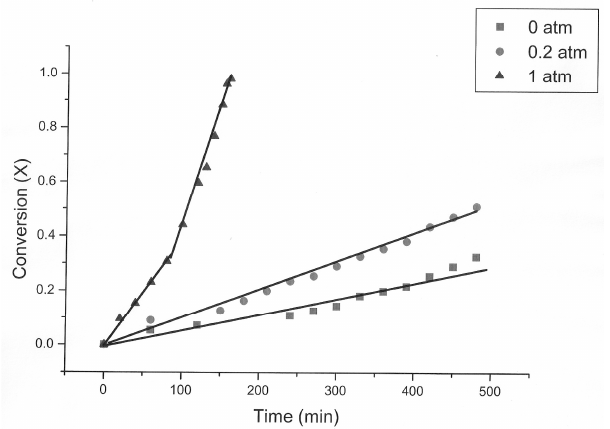
Figure 11. Effect of the partial pressure of oxygen on thiosulfate transformation: [S 2 O 3 2 − ], 1 g · L − 1 ; [Cu 2+ ] initial , 0.053 g · L − 1 ; pH constant , 5; 60 °C.